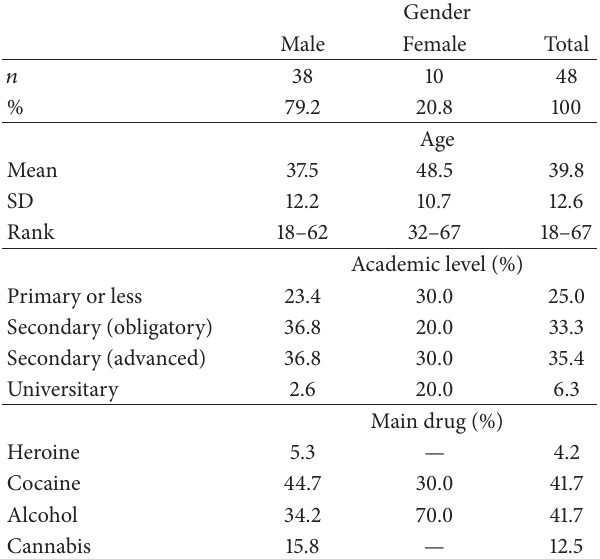
Table 1: Descriptives of the